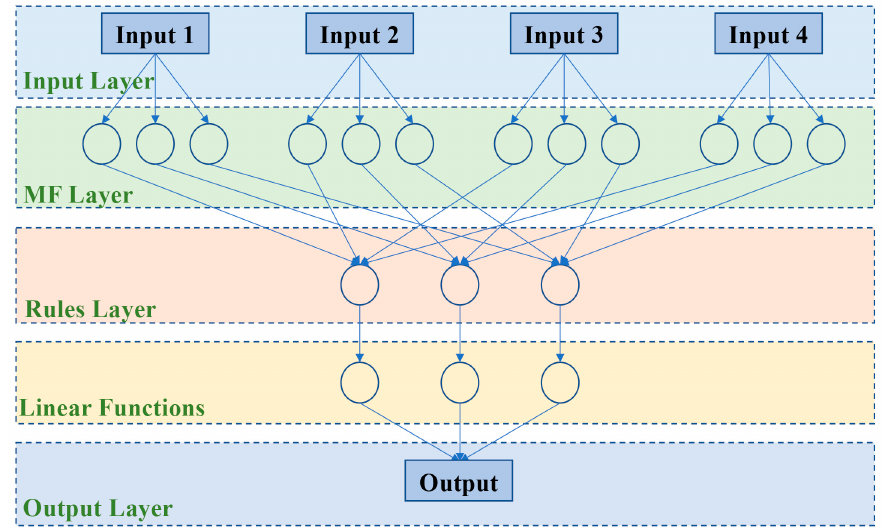
Figure 1. An example of the ANFIS model with four inputs and three membership functions for each input.